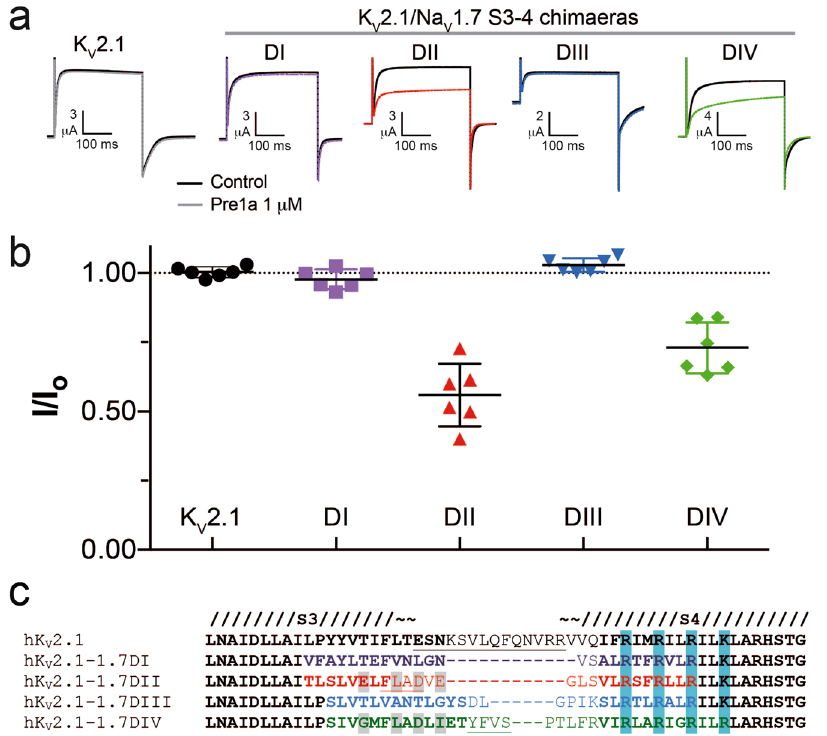
Figure 6. Pre1a can interact with the DII and DIV S3-S4 linker of hNa V 1.7. (a) Representative traces showing the effect of Pre1a (1 µ M) on K V 2.1 and chimaeras of K V 2.1 containing S3-S4 linker region from each domain of hNa V 1.7. (b) Normalised peak-current inhibition by Pre1a (1 µ M) for each K V 2.1/hNa V 1.7 chimaera (n = 6). Chimaeras of K V 2.1 with the hNa V 1.7 DII and DIV had peak current inhibited after addition of 1 µ M Pre1a by 44.0 ± 4.6% and 27.1 ± 3.8%, respectively. (c) Alignment of K V 2.1/Na V 1.7 chimaera S3-S4 regions. Grey highlight indicates the residues determined by Xiao et al . 23 to be key for HwTxIV functional effects on hNa V